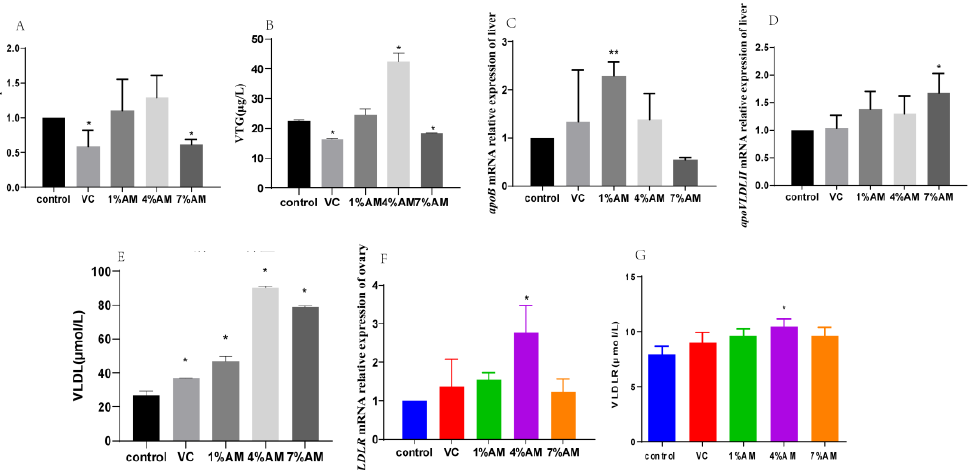
Figure 6. Effects of feed supplemented with AM on yolk precursor and receptor. VTGII ( A ), apoB ( C ) and apoVLDLII ( D ) gene expressions in liver, VLDLR ( F ) gene expression in ovary, VTG ( B ), VLDL ( E ) and VLDLR ( G ) content in serum. Values are shown as mean ± SD ( n = 6). Significant differences compared to control group are designated as ** show very significant difference at p < 0.01, * show significant difference at p < 0.05. Abbreviations: VTG, vitellogenin, VLDL, Very low density lipoprotein, VLDLR, very low density lipoprotein receptor.